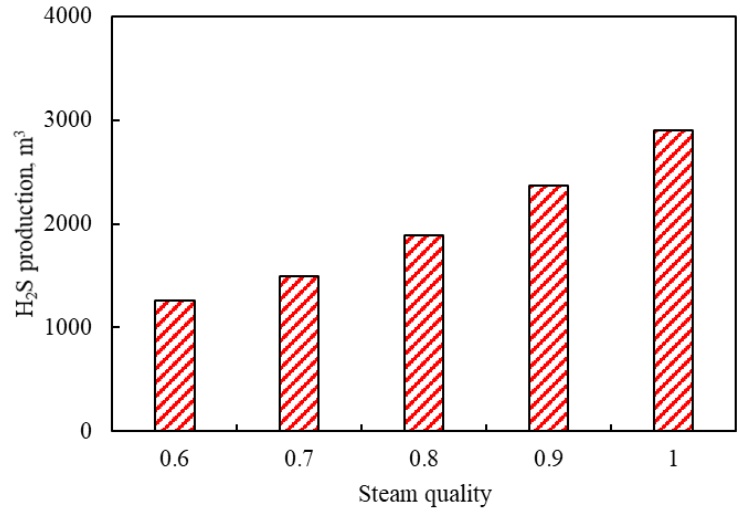
Figure 10. Effects of steam quality on H 2 S production.